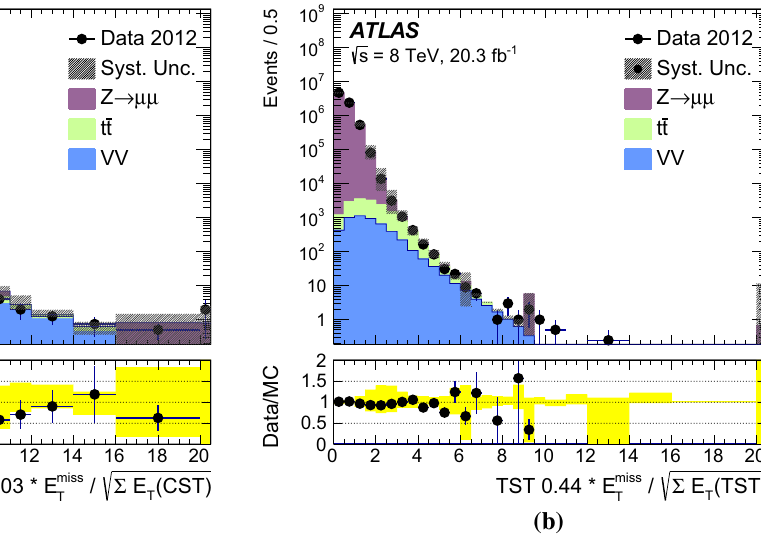
tistical and systematic uncertainties, and the insets at the bottom of the figures show the ratios of the data to the MC predictions. The far right bin includes the integral of all events above 20